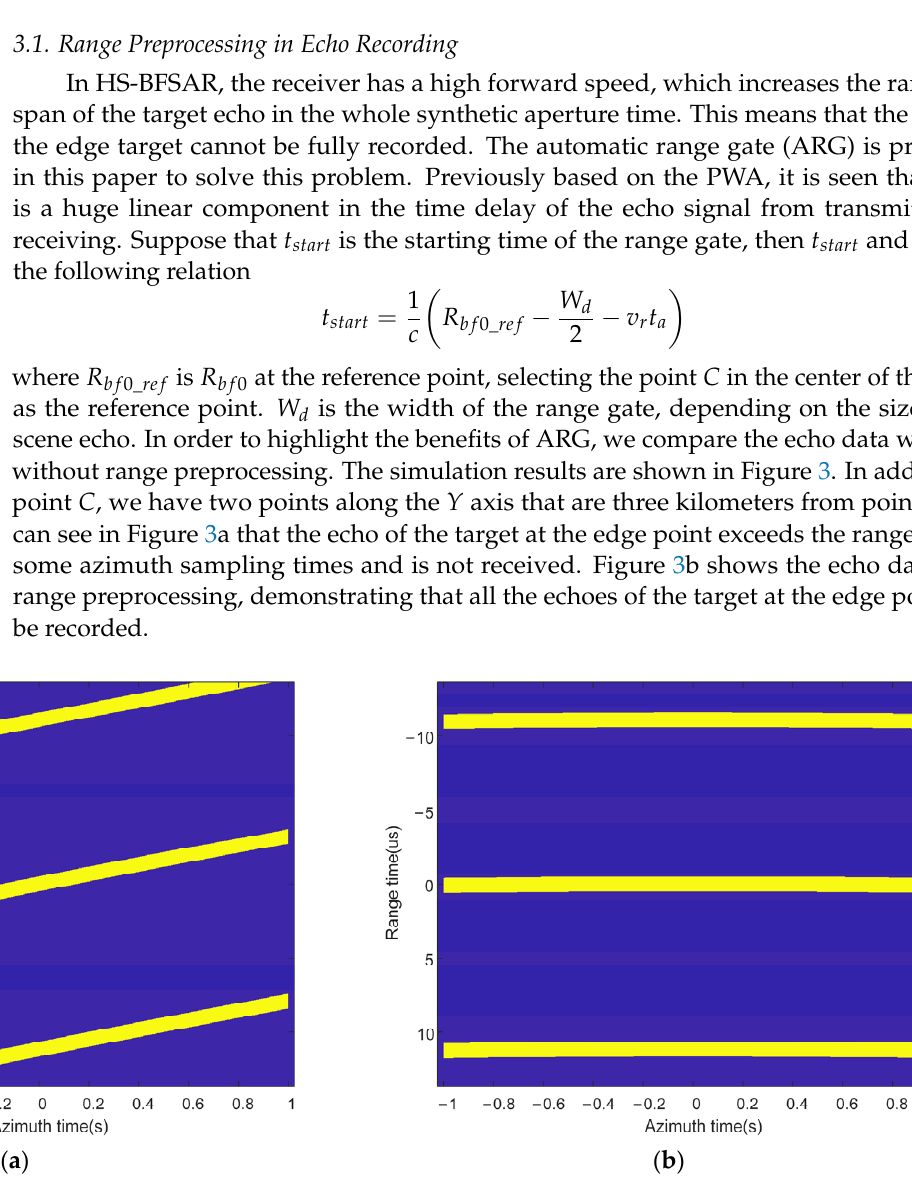
Figure 3. The simulation echo data without and with range preprocessing. ( a ) No range preprocessing when recording echo; and ( b ) using range preprocessing when recording echo.